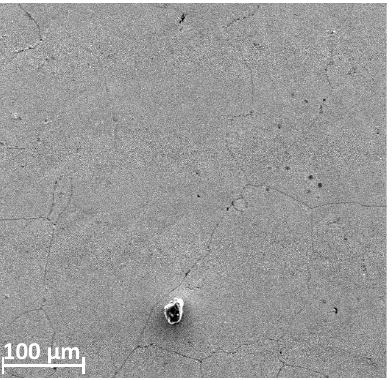
Figure 10. Topography of the endoprosthesis in the undamaged area with a single artefact. Materials 2020 , 13 , x FOR PEER REVIEW